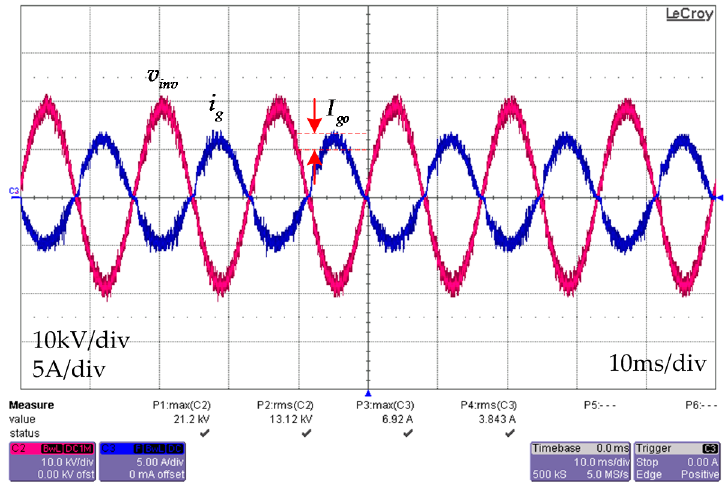
Figure 20. The switching voltage and the input current of the AFE converter cascaded in 10 modules with a current offset.